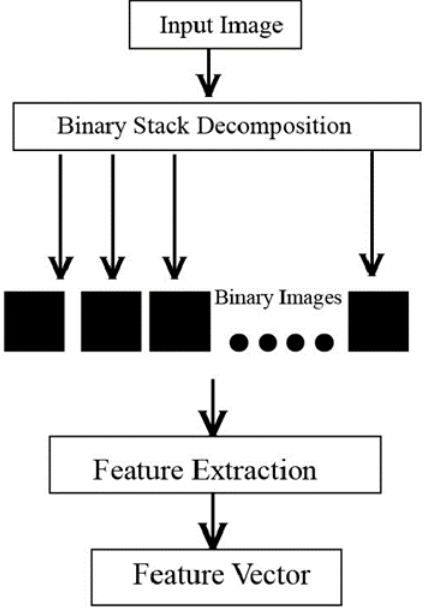
Figure 2. SFTA Extraction process